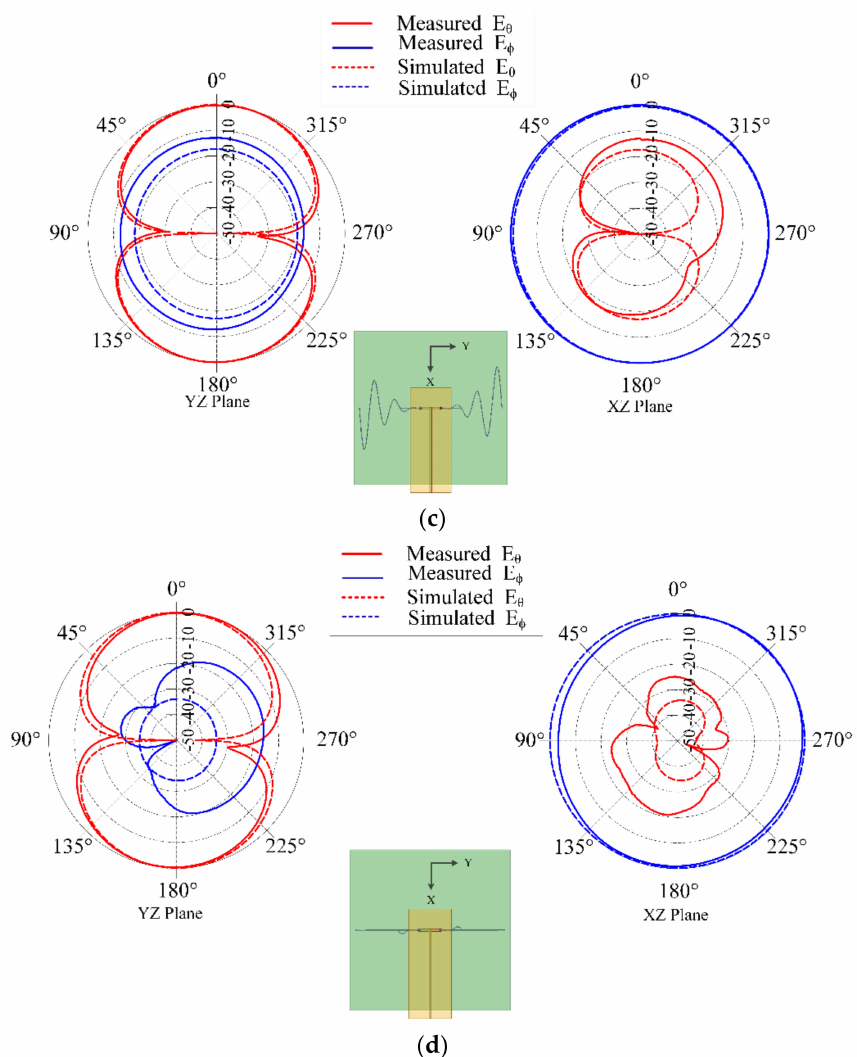
Figure 6. Measured and Simulated radiation pattern in yz- (left) and xz-planes (right) for different scenarios ( a ) t 1 = 0.8 in. and t 2 = 0.8 in. at f =1.681 GHz; ( b ) t 1 = 1.6 in. and t 2 = 1.6 in. at f = 0.74 GHz; ( c ) t 1 = 2.4 in. and t 2 = 0.8 in. at f = 0.372 GHz; and ( d ) t 1 = 0.8 in. and t 2 = 2.4 in. at f = 0.8